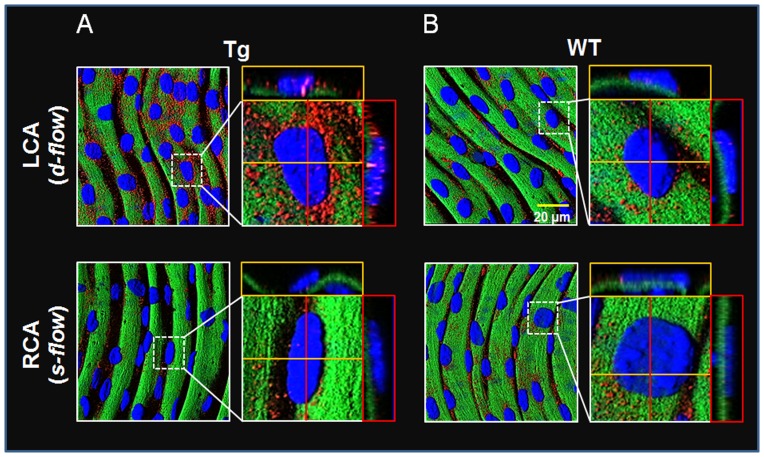
Potentiation of disturbed flow-stimulated NF-κB activation by nuclear Trx1.WT and NLS-Trx1 Tg mice ligated in LCA were examined for p65 NF-κB expression and nuclear localization using en face fluorescence confocal examination (red, p65 NF-κB; green, elastic layer; blue, DAPI; magenta, overlapping DAPI and p65).